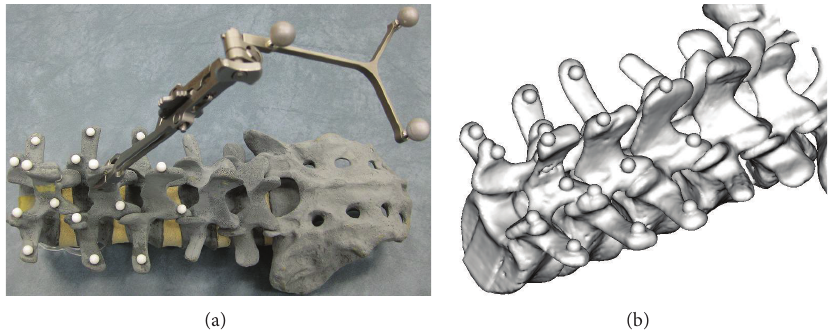
Figure 9: (a) The vertebra phantom with fiducial markers and a DRF attached. (b) The reconstructed CT model.